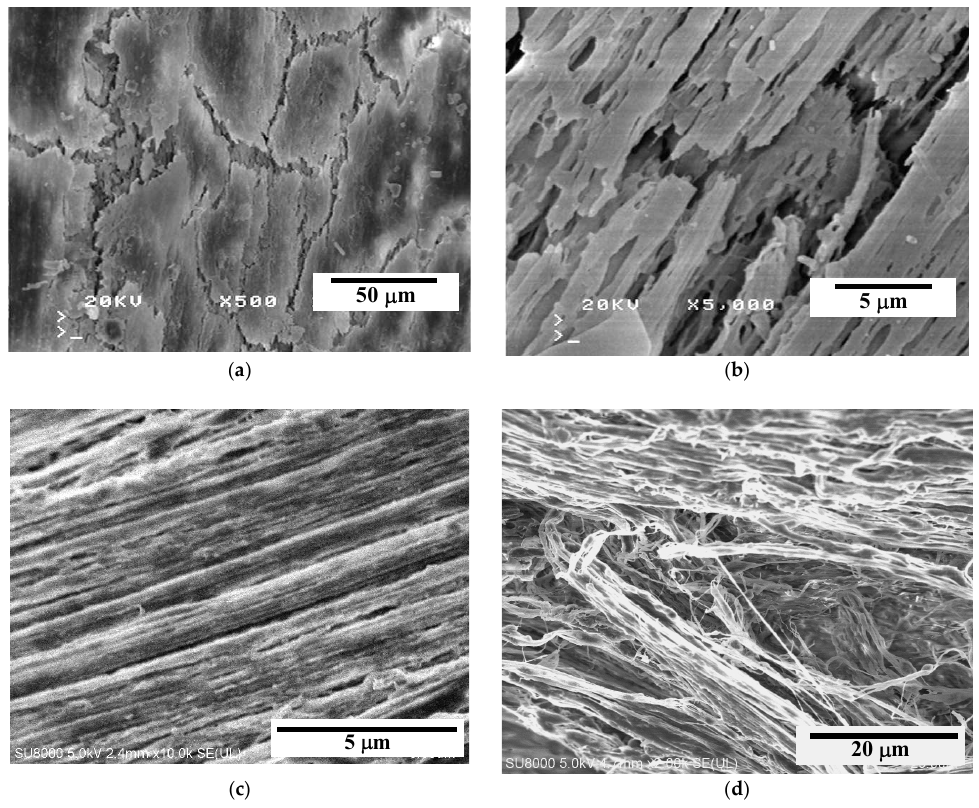
Figure 9. SEM images of PP membranes after MD process. Membrane PP-N: ( a ) external surface; ( b ) external surface magnification; ( c ) internal surface; ( d ) external surface of PP-T membrane.